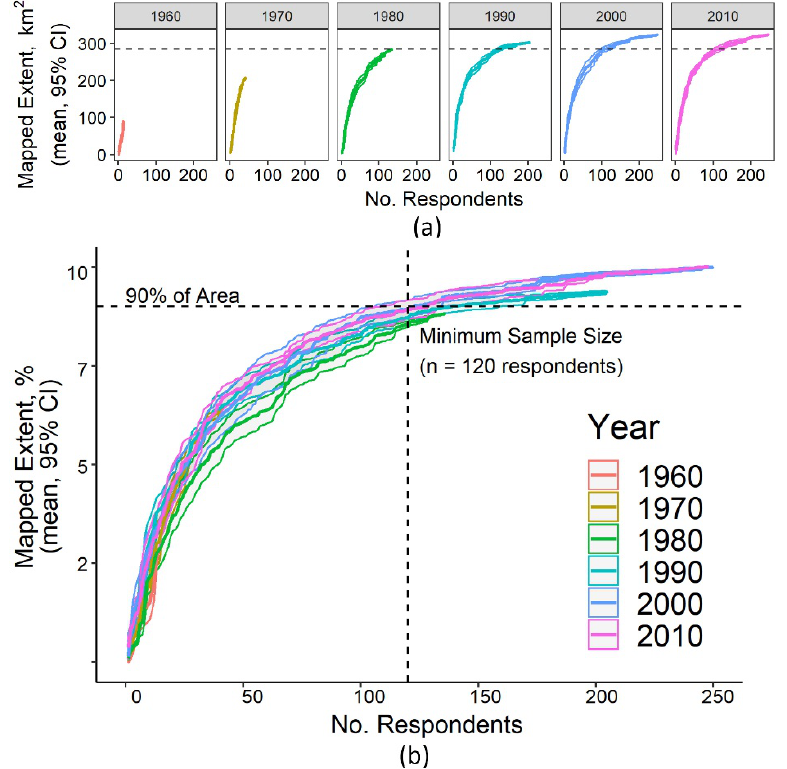
Figure 6. Historical resource use captured by participatory mapping and accounting for increasing numbers of maps over time. Panel ( a ) shows respondent numbers necessary to capture 90% of the maximum extent of fishing (estimated as per panel ( b )). The percentage of the maximum extent captured in mapping varied across decades in part because information was gathered from fewer respondents (e.g., in more distant years, some respondents were not yet born). Vertical dashed line identifies the minimum number of respondents ( n = 120) needed to capture 90% of the mean maximum fished area. Panel ( b ) shows separate rarefaction curves as per panel ( a ) for each of six decades (1960–2010), depicting the estimated extent of fishing grounds as a percentage of the mean cumulative area of fishing grounds. Notably, only three recent decades reached an asymptote (1990, 2000, 2010), signaling that su ffi cient sampling was achieved in those decades. The mean maximum extent of fishing grounds (estimated from these three decades) was 319.94 km 2